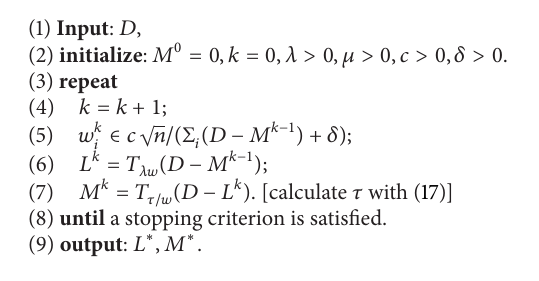
Algorithm 2: Solving WNSMP with reweighted dual